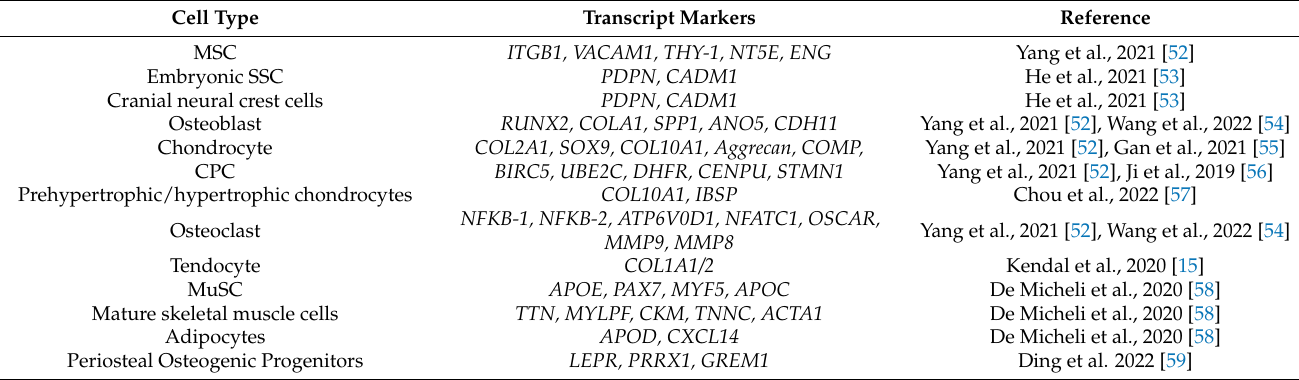
Table 1. Common cell types and markers of the musculoskeletal